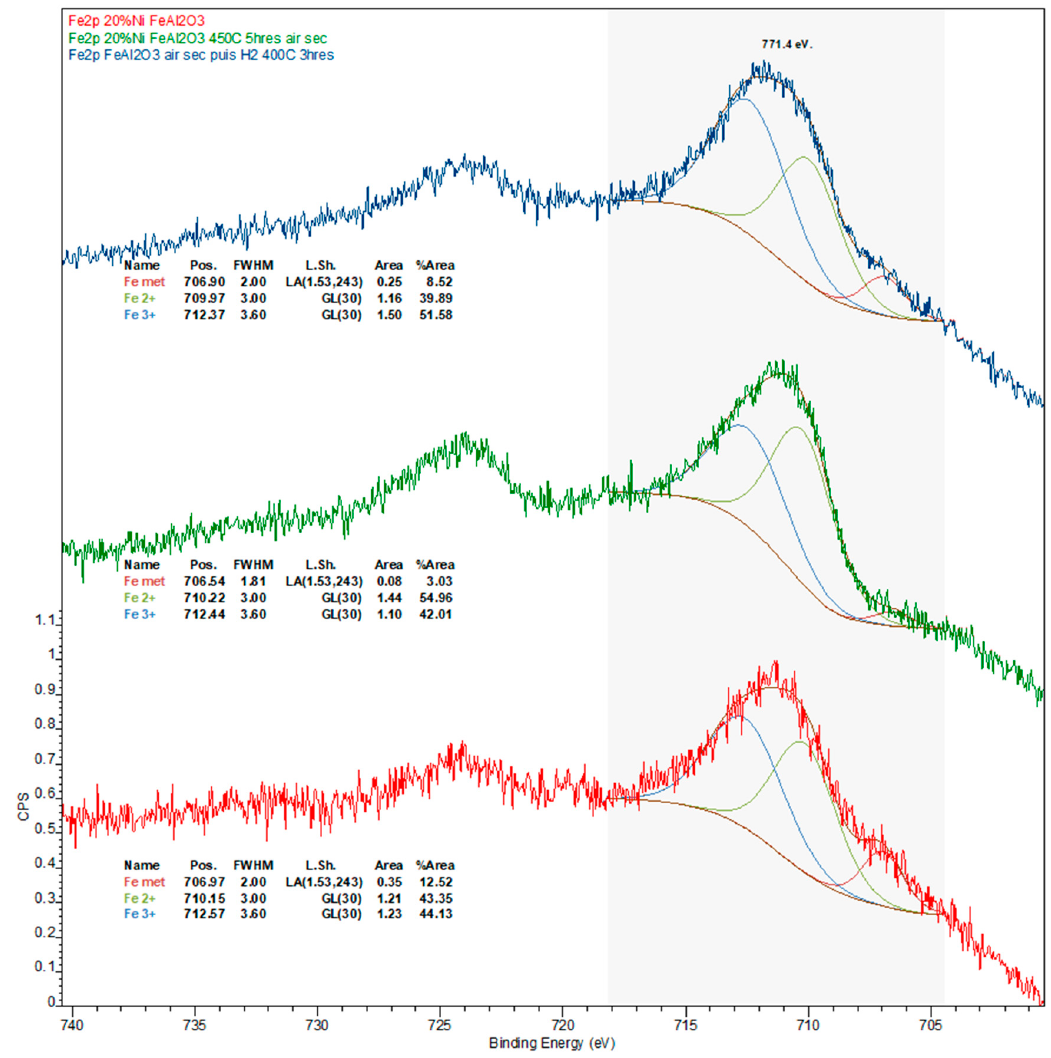
Figure A8. Iron 2p X-ray photoelectron spectra of the spent Ni-Fe catalyst after the deoxygenation experiment (red spectrum), after calcination in air at 450 ◦ C for 5 h (green spectrum), and reduction under H 2 at 400 ◦ C for 3 h (blue spectrum).